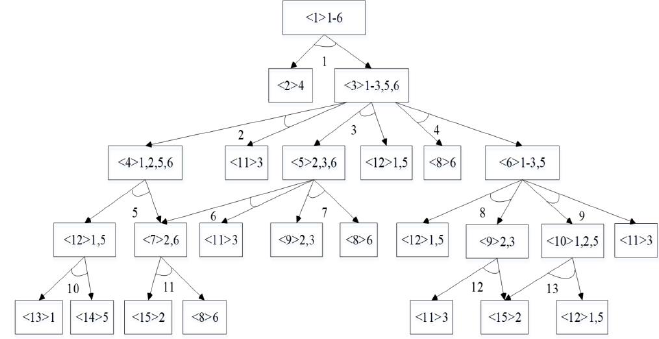
Figure A5. AND/OR graph of a hammer drill.